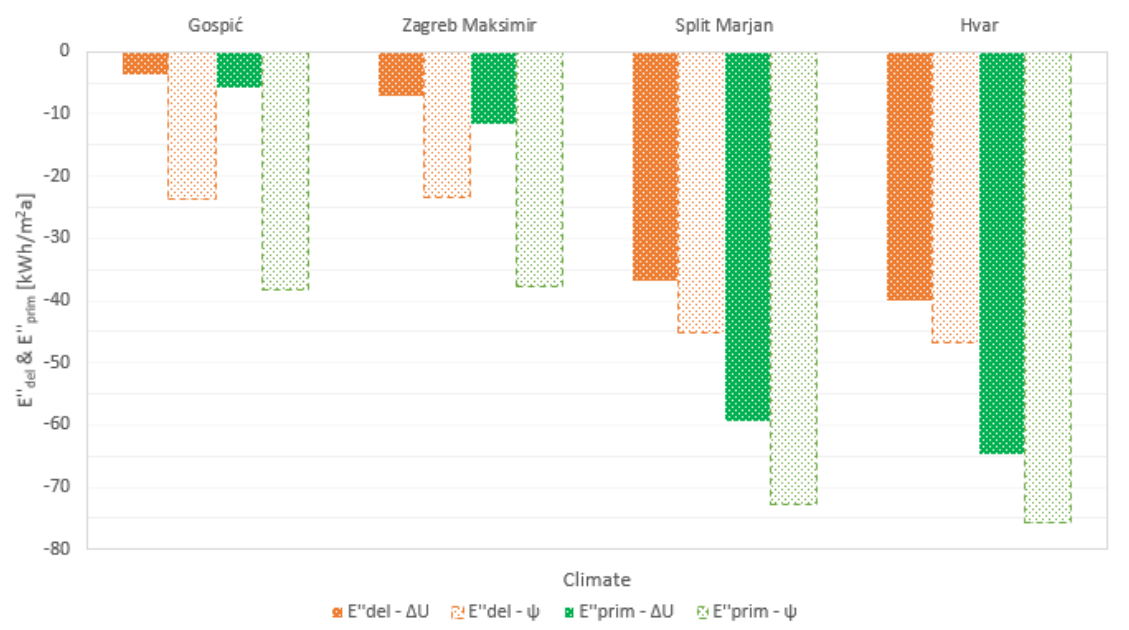
Figure 12. Delivered and primary energy use depending on the thermal bridge consideration ap- proach.